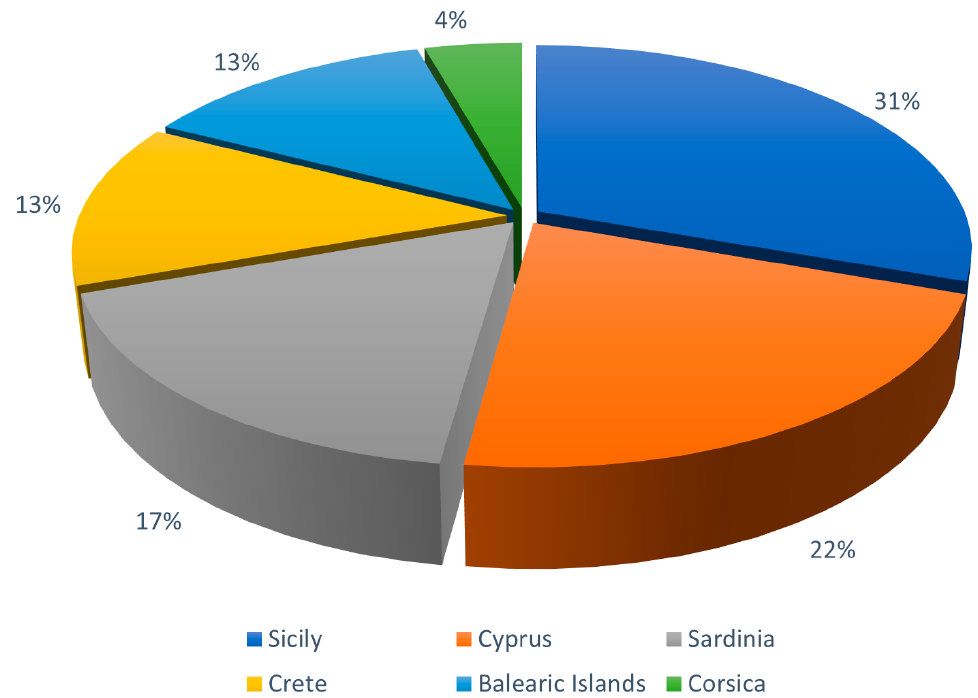
Figure 5. Percentage of all “Extreme rainfall events” articles of Mediterranean bioregion grouped into islands.